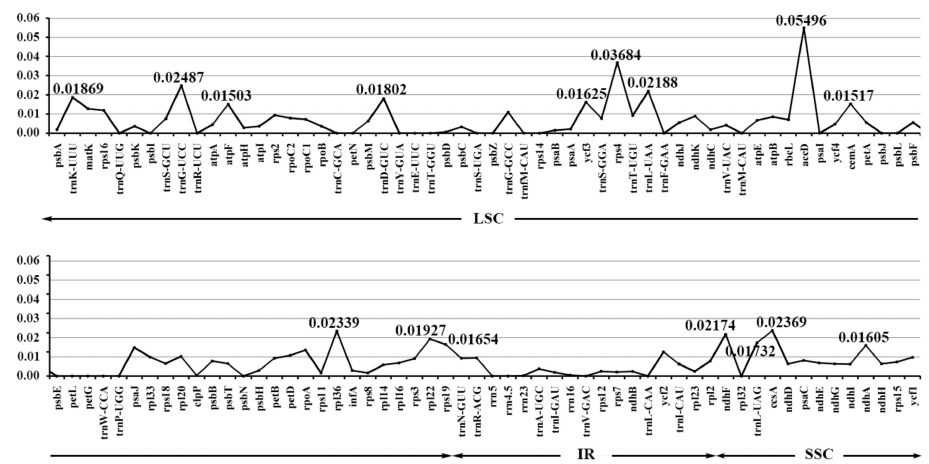
Figure 4. The nucleotide diversity of the whole chloroplast genomes of the three species. LSC: large single-copy region; IRs: inverted repeats region; SSC: small single-copy region.